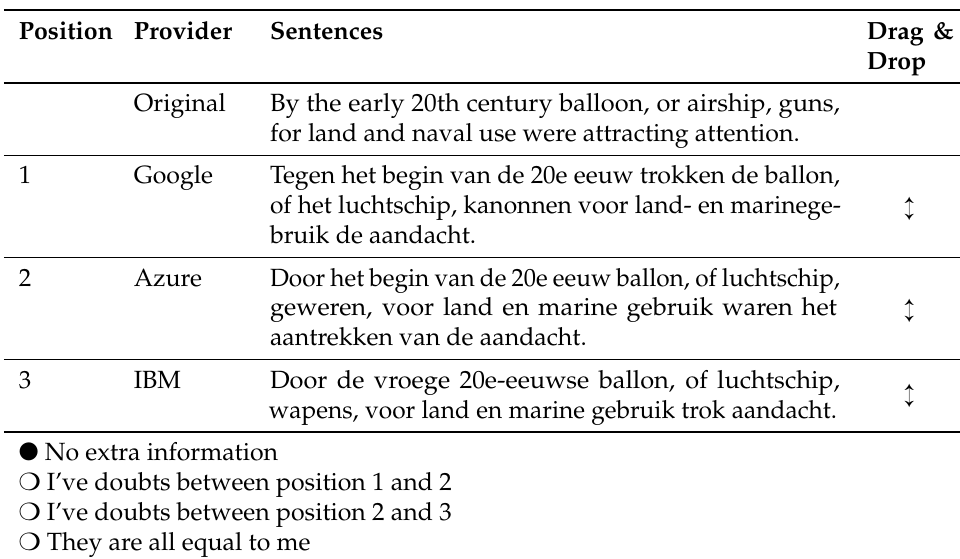
Table 1. Example of different machine-translated texts with the original. In this example, Google is selected as